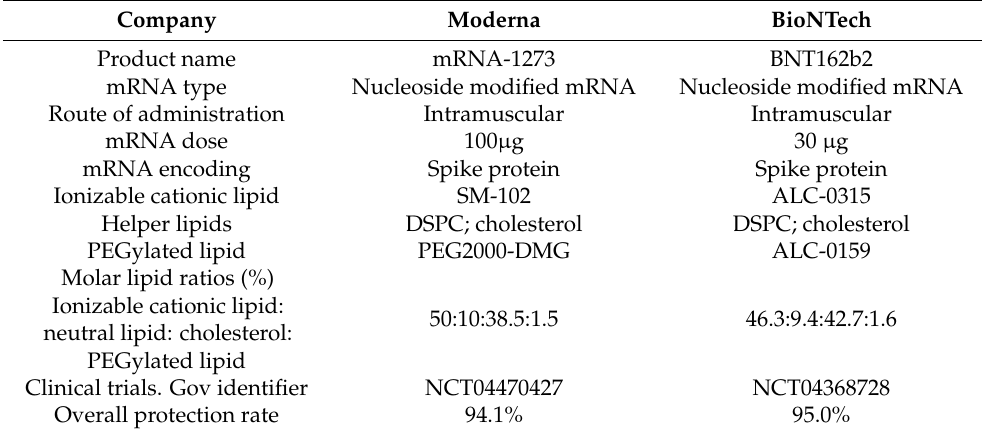
Table 2. Information about marketed mRNA–LNP drug products for COVID-19